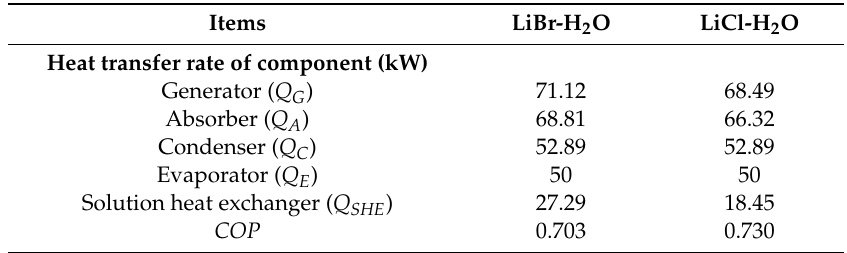
Table 4. Single e ff ect absorption chiller performance parameters and design